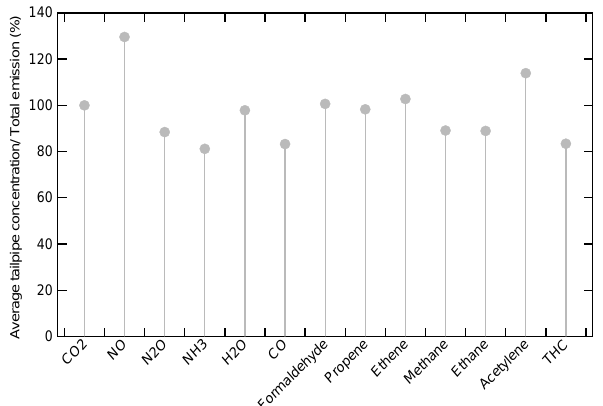
Fig. 4. CO 2 normalised concentrations of gas phase species mea- sured at the tailpipe (i.e. concentration of the constant flow in- jected into the smog chamber) vs. total mass emitted (i.e. account- ing for variable exhaust flow as a function of time), measured us- ing FTIR. Normalised concentrations are within 20% for most gas phase species, suggesting that sampling a constant flow from the vehicle exhaust yields samples with chemical composition close to those of the total